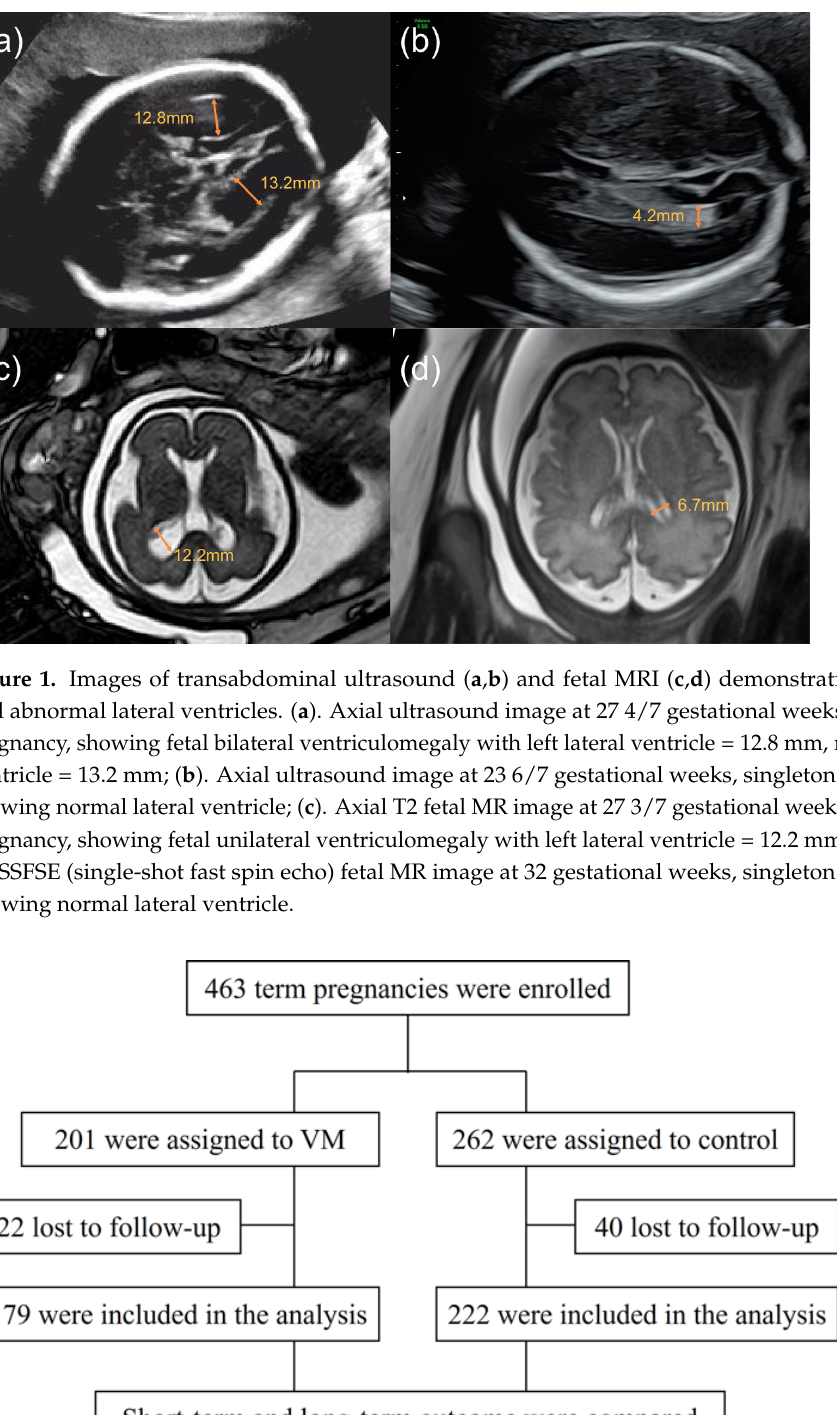
Figure 2. Profile of the cohort study. The short-term outcomes of infants were measured primarily using Apgar scores and the NICU admission during the perinatal period while long-term outcome was assessed as any clinical manifestations of abnormal neurodevelopment occurring after 1 year of birth.